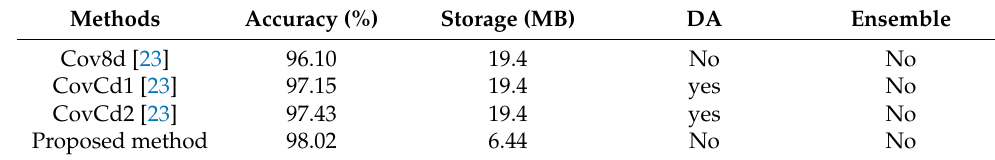
Table 4. Performance comparison of different deep-learning methods on the GB1 dataset.